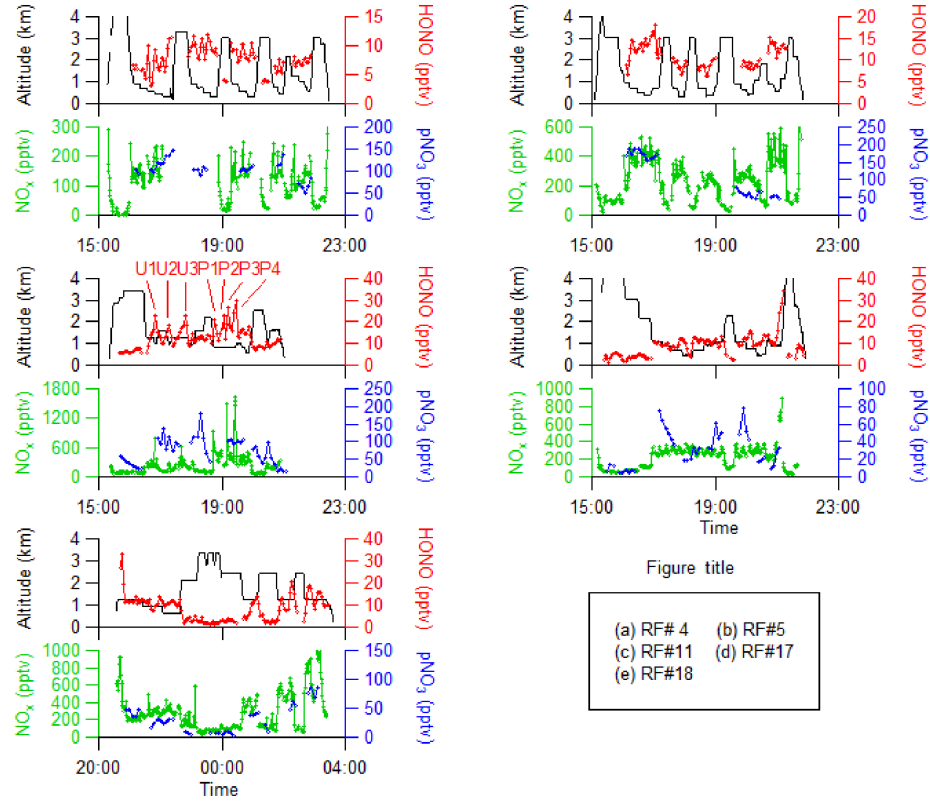
Figure 2. Time series of altitude, HONO, NO x and p NO 3 in five flights (RF 4, RF 5, RF 11, RF 17 and RF 18) in the southeastern US during the NOMADSS 2013 summer study. In RF 11, plumes U1 and U3 were from Birmingham, AL; plume U2 was from Montgomery, AL; plumes P1–P3 were from a power plant in Monroe County, GA; and plume P4 was from a power plant in Putnam County,